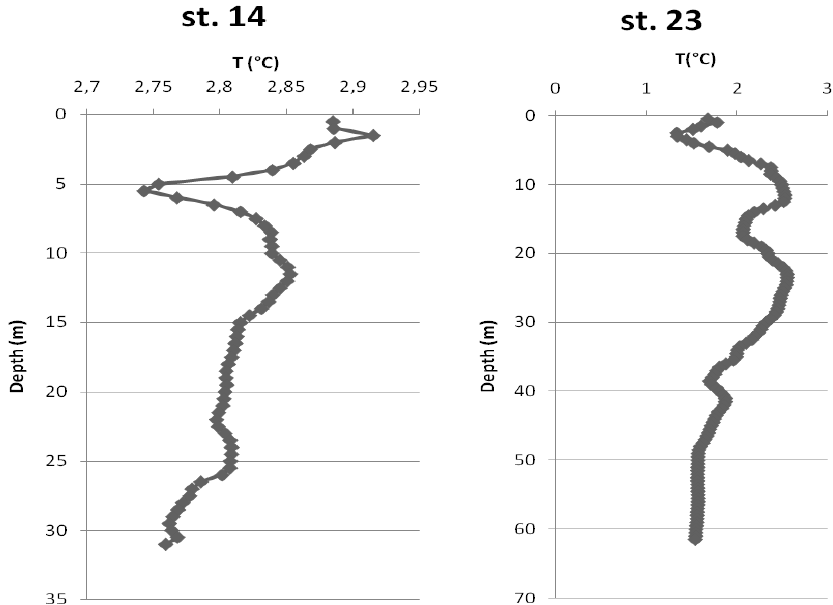
Figure 3. Vertical profiles of temperature at stations 14 and 23, showing the signal of colder waters from ice melting at 5 and 3.5 m, respectively.